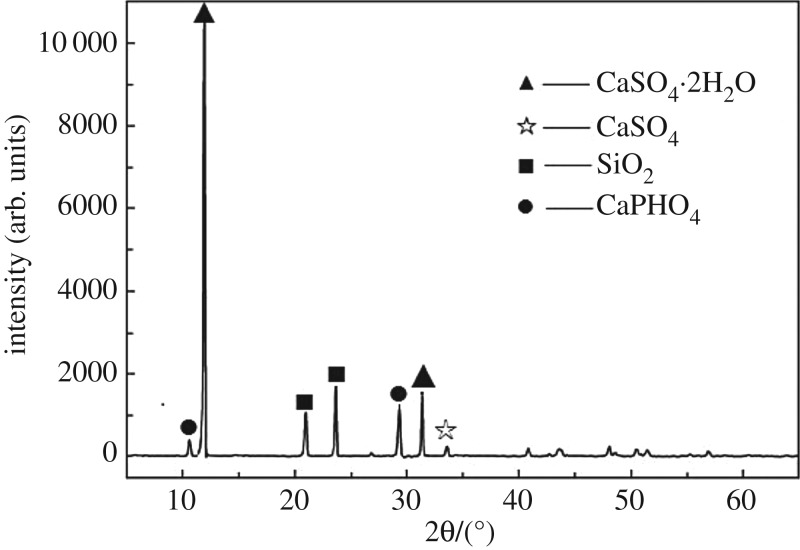
Analysis on X-ray diffraction of gypsum rock [29].